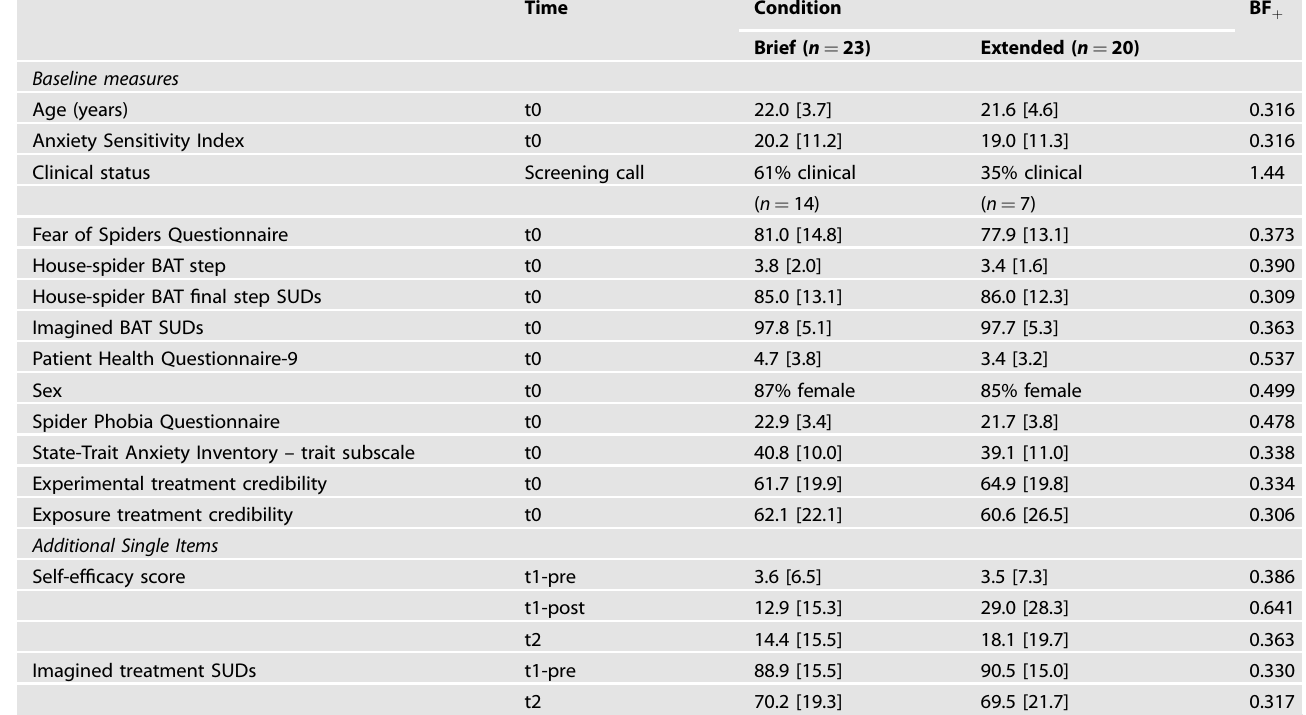
Table 1. Mean scores [SD] by group for baseline characteristics and additional single-item